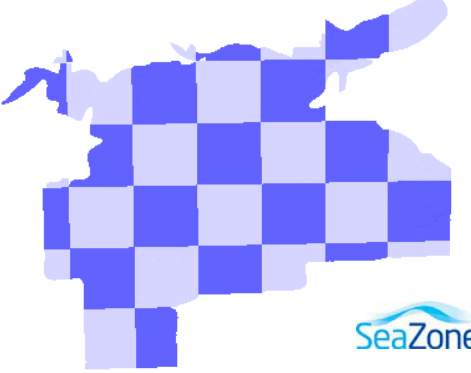
Figure 5: An example of the pattern of a tiled approximation where each tile represents one